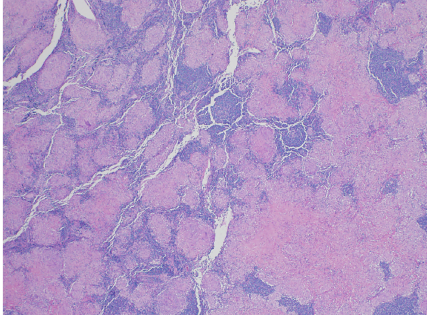
Figure 3: Right paratracheal lymph node histology; low magnifica- tion.